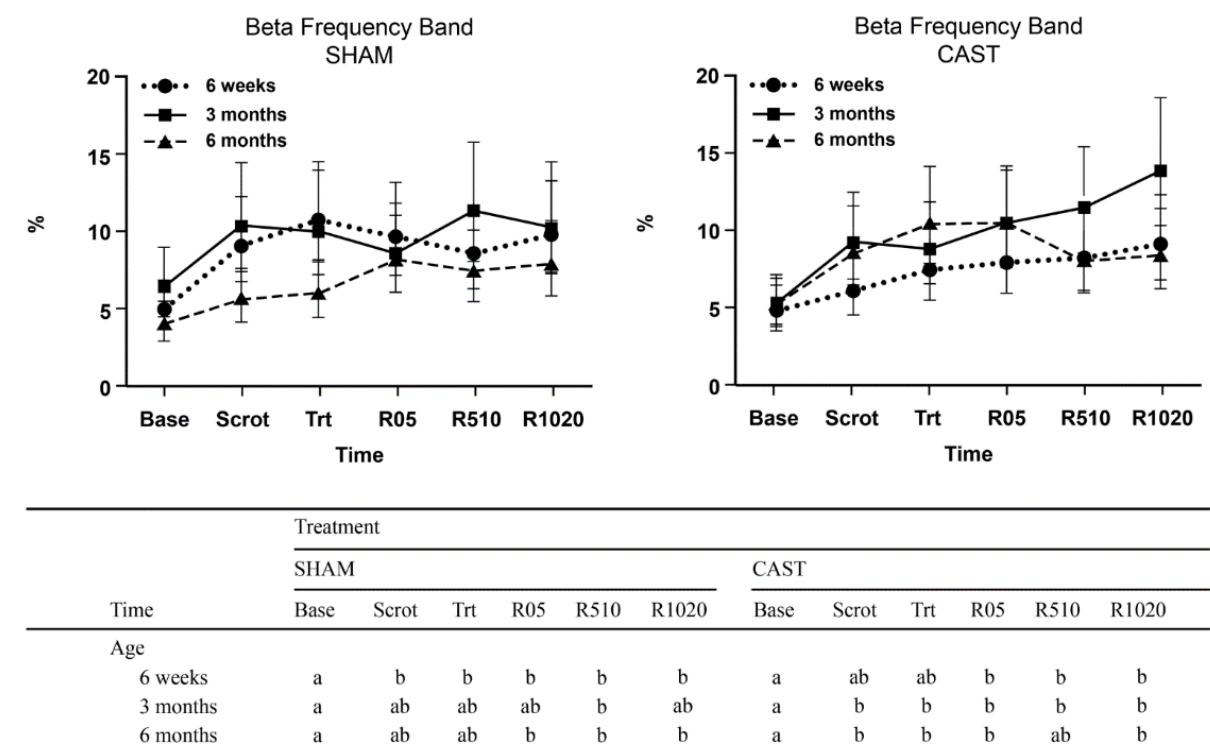
Figure 3. Estimated least-square means and 95% confidence intervals of relative power (%) of beta frequency bands for 6-week—(6W), 3-month—(3M) and 6-month-old—(6M) calves undergoing simulated castration (SHAM) and surgical castration (CAST) treatments. Time points evaluated consist of baseline (Base), scrotum manipulation (Scrot), treatment (Trt), immediate recovery (R05), middle recovery (R510), and late recovery (R1020). The letters (a, b) indicate a significant difference ( p < 0.05) between time points within each combination of age category treatment.